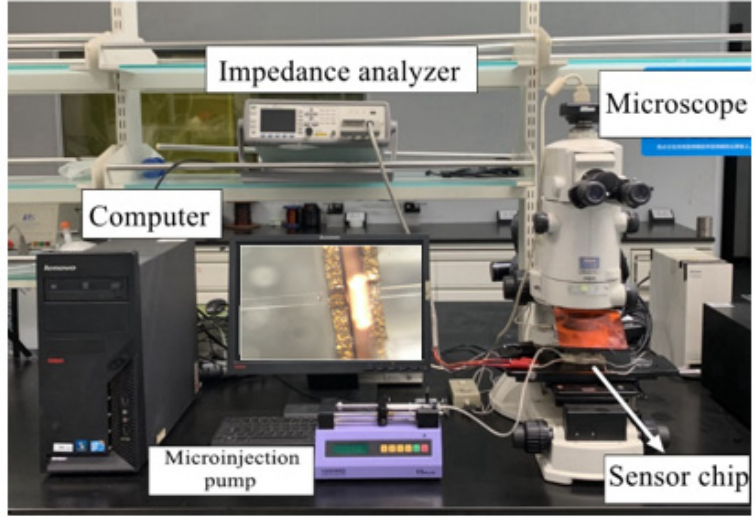
Figure 8. Experimental system.